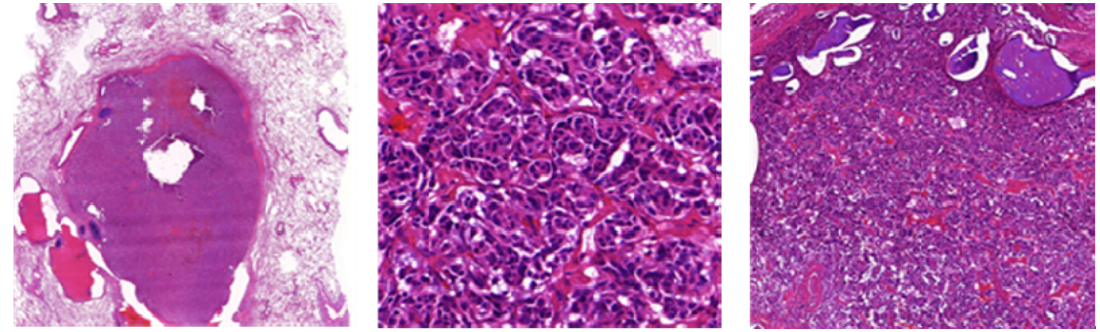
Figure 7. Atypical carcinoid tumor with vascularized stroma, focal necrosis and more than 2 mitosis/2 mm².